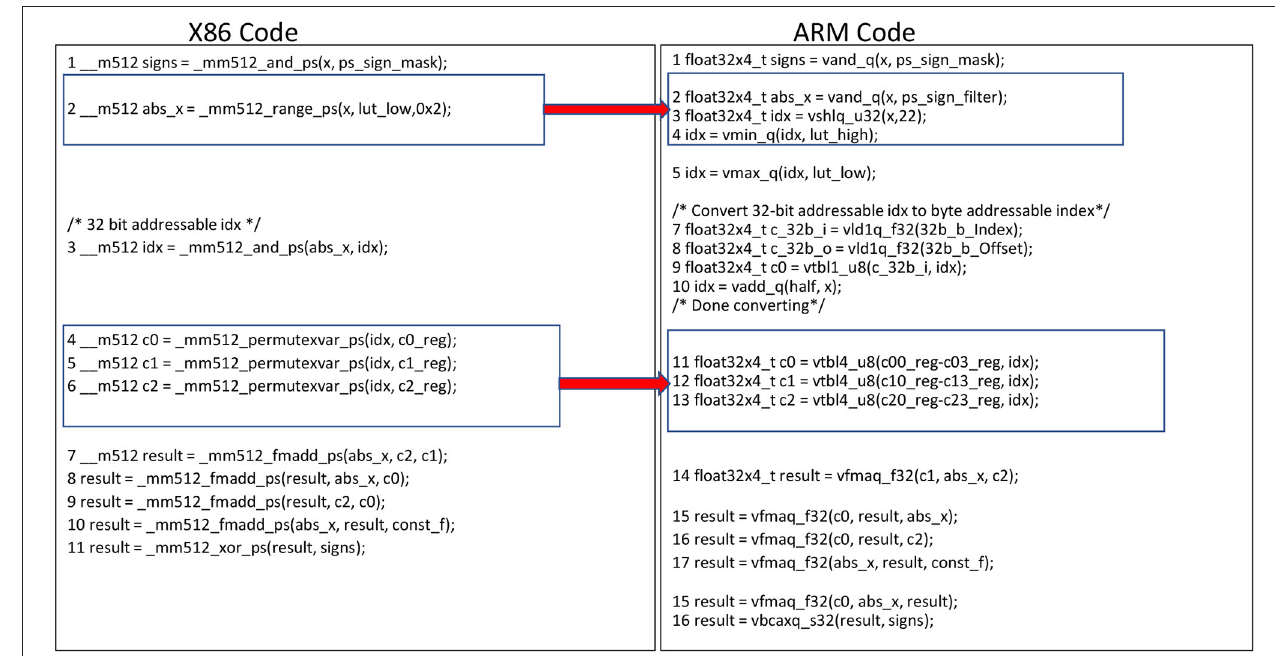
FIGURE 8 | Tanh minimax approximation pseudocode with equivalent intrinsics on x86 and Arm/AArch64. We highlight here how the _mm512_range_ps instruction on x86 ISAs has an equivalent instruction sequence on AArch64. Also the permutes on x86 have equivalent Table lookup instructions on